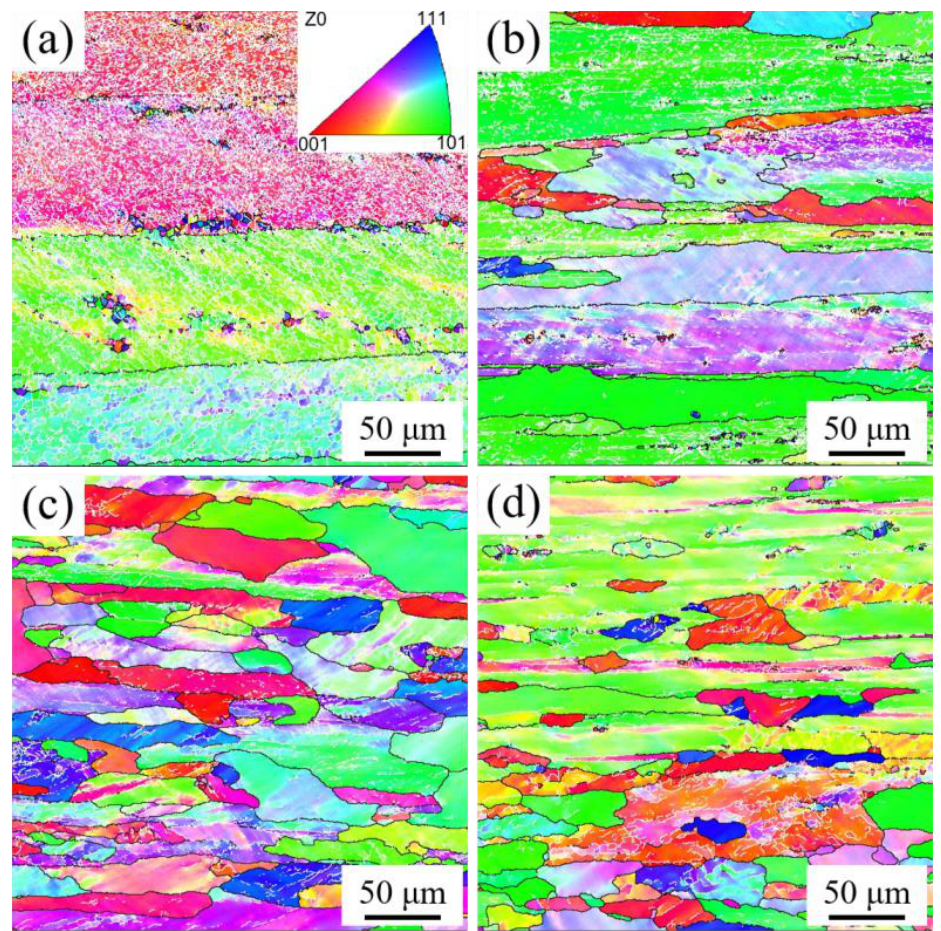
Figure 4. Orientation maps and inverse pole figure ( a ) AL1; ( b ) AL2; ( c ) AL3; ( d ) AL4. As shown in Figure 4a, the grains of AL1 alloy are elongated significantly after hot rolling with fibrous shape along the rolling direction, exhibiting a large aspect ratio. There are a large number of LAGB in the fibrous shape grains, which indicates the presence of a few recrystallization grains during hot rolling. When the Ce addition is 0.1%, the microstructures keep elongated grains and the number of grain increased, as shown in Figure 4b. Meanwhile, it can be seen that some recrystallized structures appear, and the degree of recrystallization increases compared with AL1 alloy. With the increase of Ce content to 0.2%, the number of coarse elongated grains of the alloy decreased. The grain aspect ratios reduce and grain shape tends to spheroidize, as shown in Figure 4c. When the Ce content increases to 0.3%, the grain size of the AL4 alloy changes slightly, as shown in Figure 4d. However, the low angle grain boundary is significantly lower than that in Figure 4c. Figure 5 illustrates the microstructures of AL1-AL4 alloys after hot rolling. The defor- mation grains, sub-structured grains (recovered with sub-grains), and recrystallized grains of four alloys are shown in Figure 5 in three colors (red, yellow, and blue, respectively). According to average misorientation angles, these grains are classified as recrystallized grains when their average misorientation angle is above 15 ◦ , and as sub-structured grains if their average misorientation angle is between 3 ◦ and 15 ◦ . The grains are defined as deformation grains when their average misorientation angle is below 3 ◦